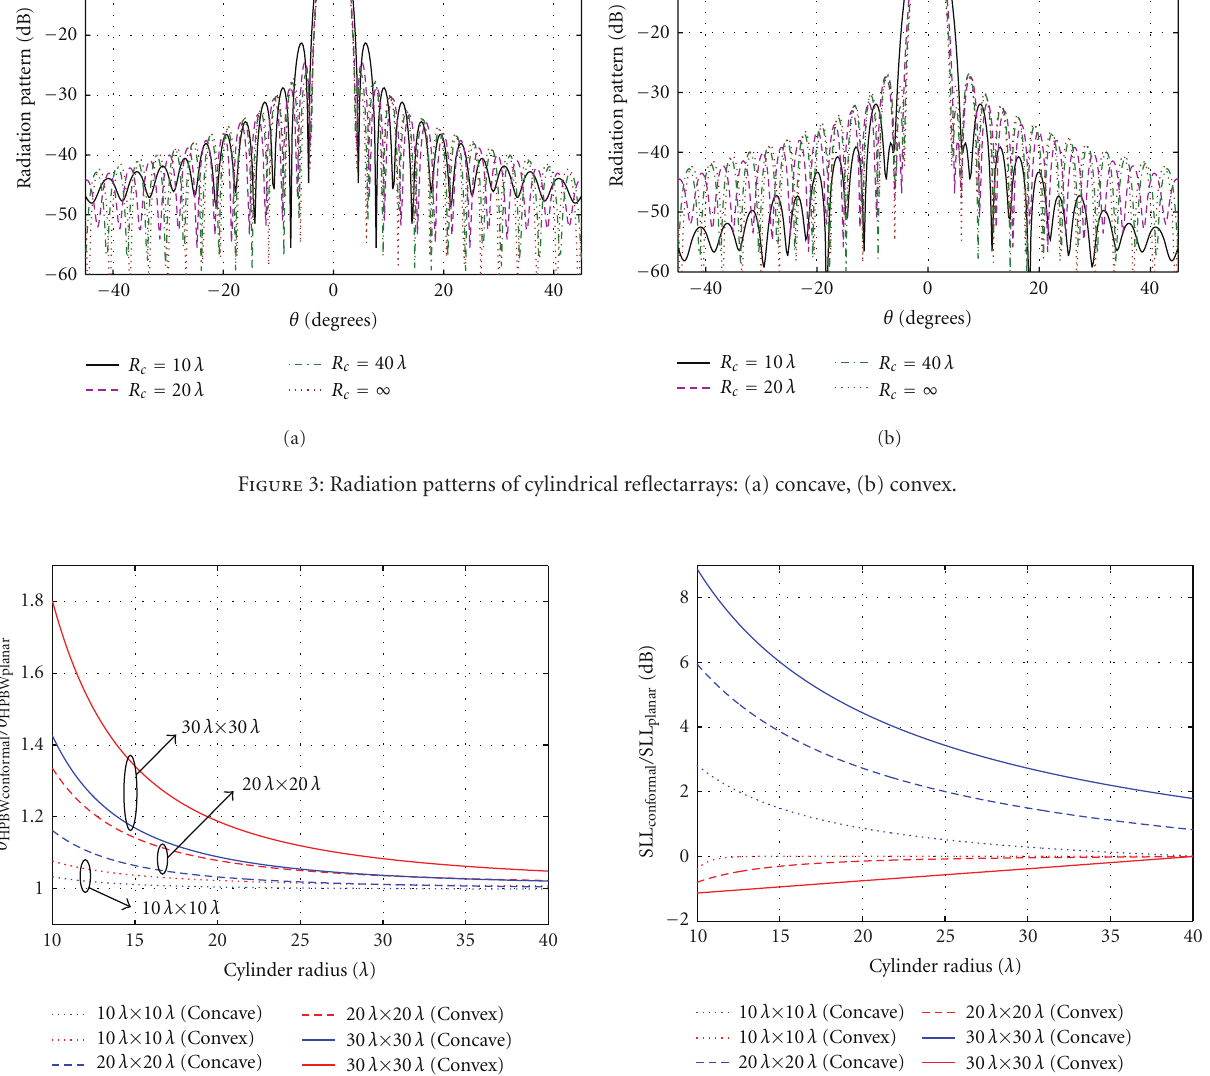
Figure 5: Normalized SLL in the curvature plane as a function of cylinder